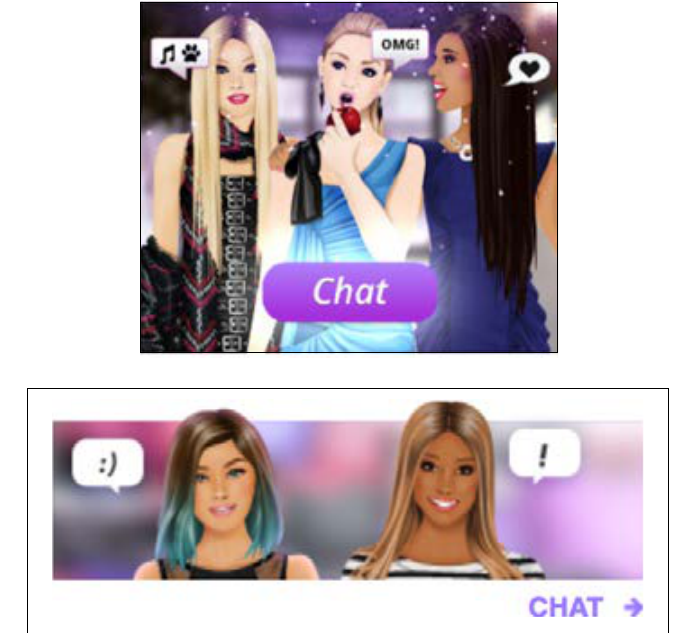
Figure 10 (bottom): This is no isolated phenomenon. The entertainment platform Stardoll (stardoll.com) for young girls also shows a chat banner depicting women with speech bubbles who only communicate by means of symbols (smiley and exclamation marks and music symbol/paw respectively, ‘OMG’ and heart). A sense of purpose is not recognisable here. No content is being communicated but only emotional expressions are presented. Women are being shown as passive beings in the role of an observer and are not represented in an active role. This is the icing on the cake of the already dubious body images (slim, long-haired, dressed-up, unrealistic). Source: stardoll.com. Accessed: November 17,